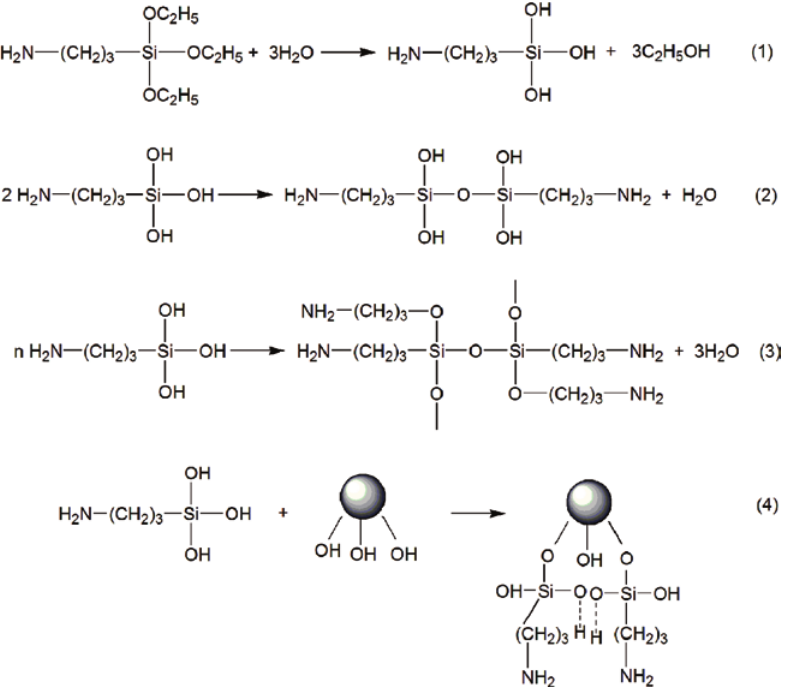
Figure 2: The action mechanism of KH550 on the diamond surface in aqueous alcohol solvent.